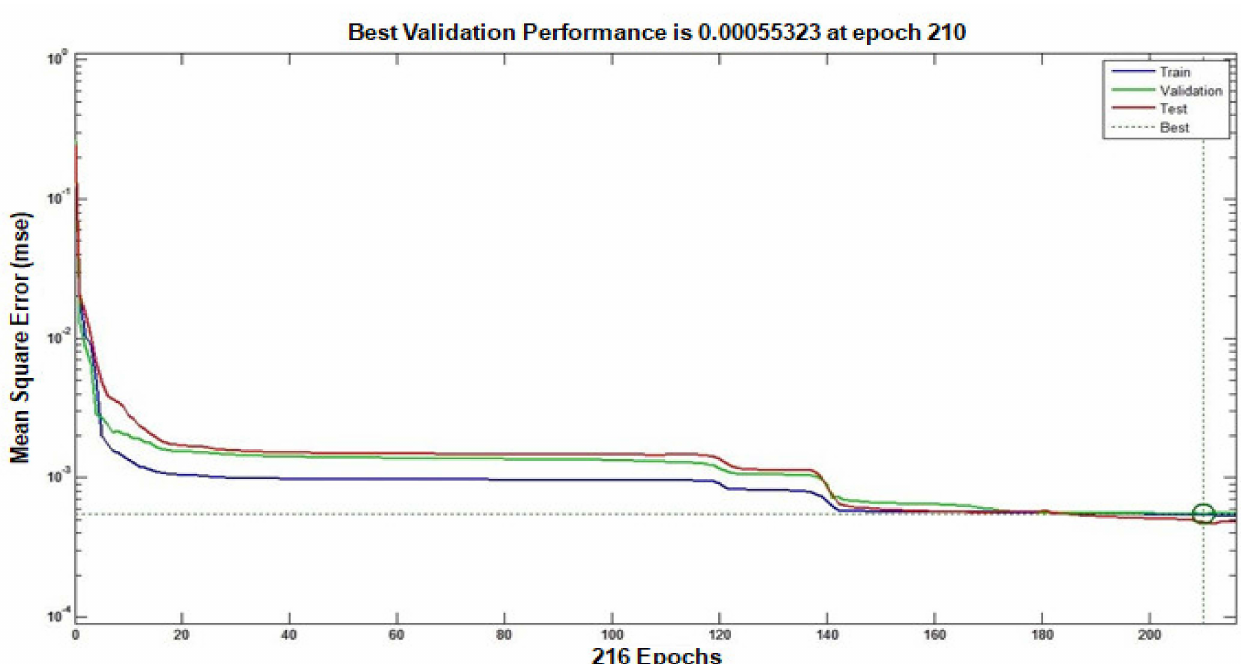
Figure 12. Performance graph of network 4-4-3 for angular distortion with time gap between two, three and four passes.